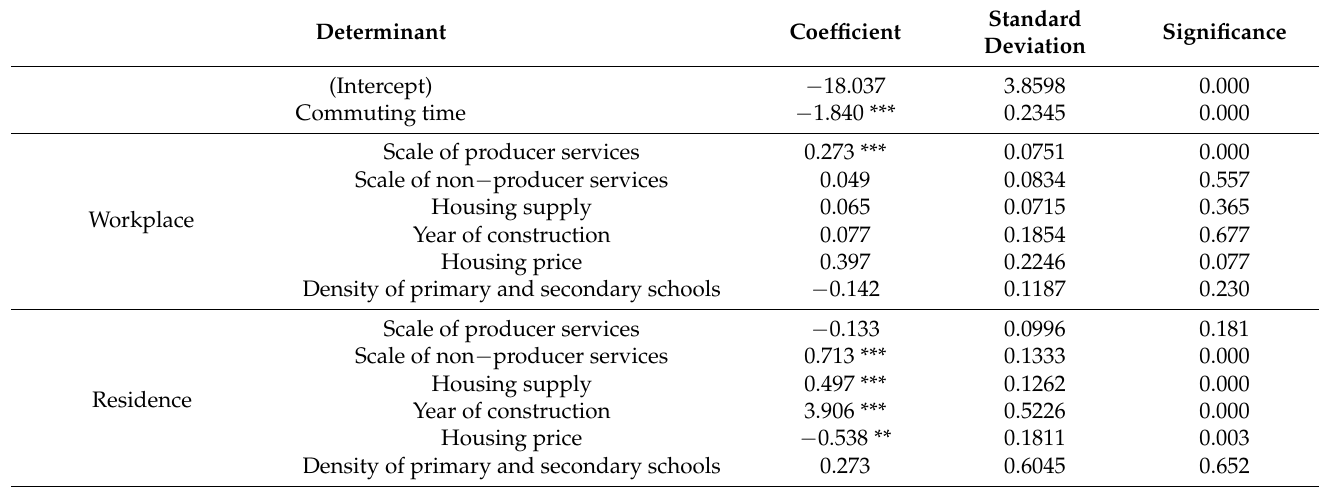
Table 4. Estimated coefficients from NB